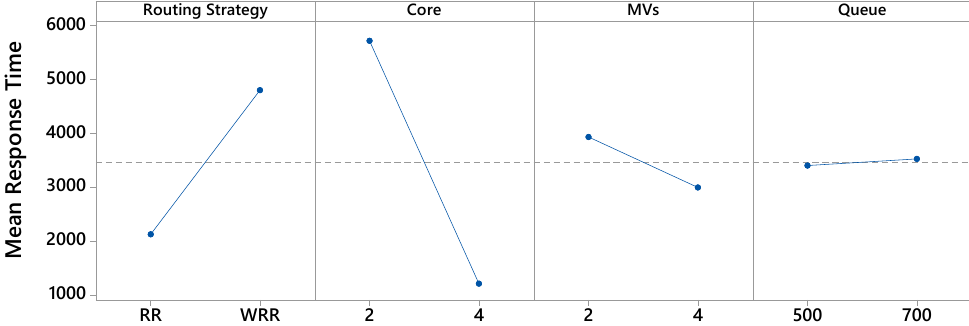
Figure 5. Main effects for the average response